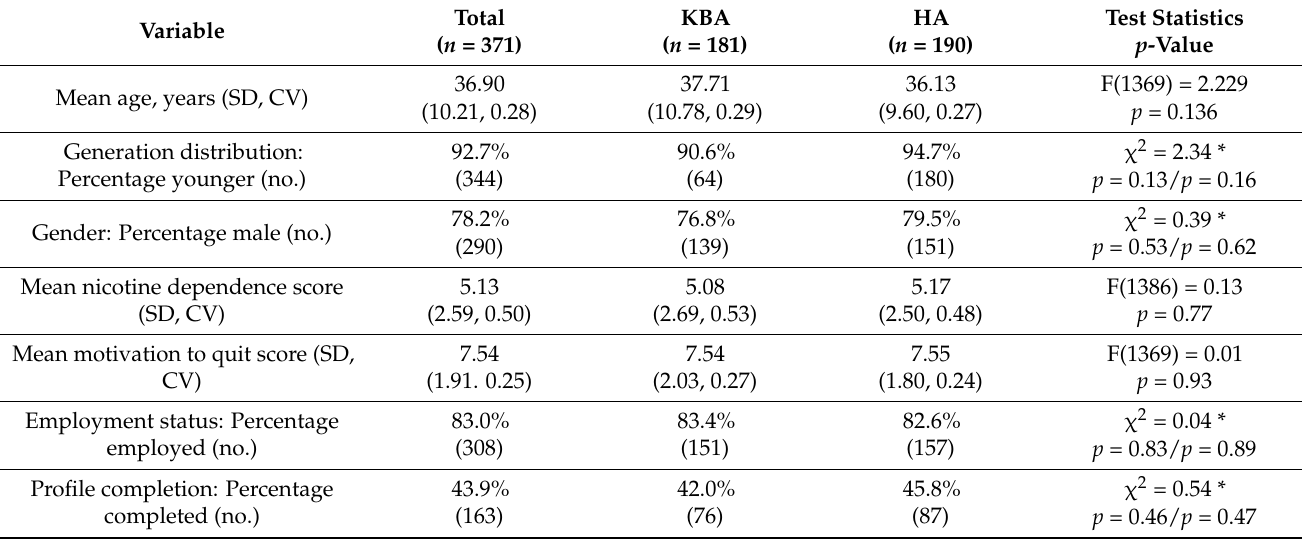
Table 2. Participants’ demographic and smoking characteristics distribution between